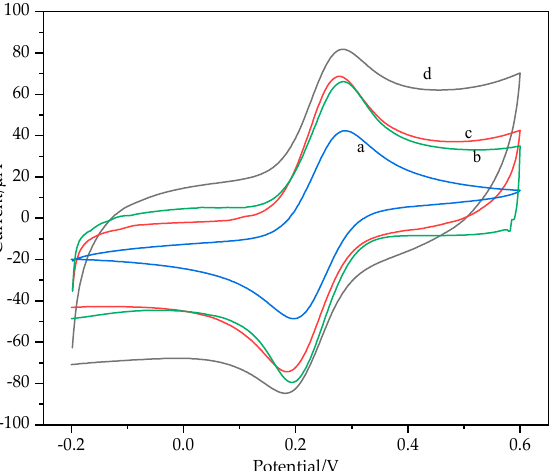
Figure 4. Cyclic voltammetry (CV) curves of Bare GCE (a), ERGO/GCE (b), MXene/ERGO/GCE (c), and AuNPs/MXene/ERGO/GCE (d) in 0.1 M KCl solution containing 5 mM [K 3 Fe(CN) 6 ].